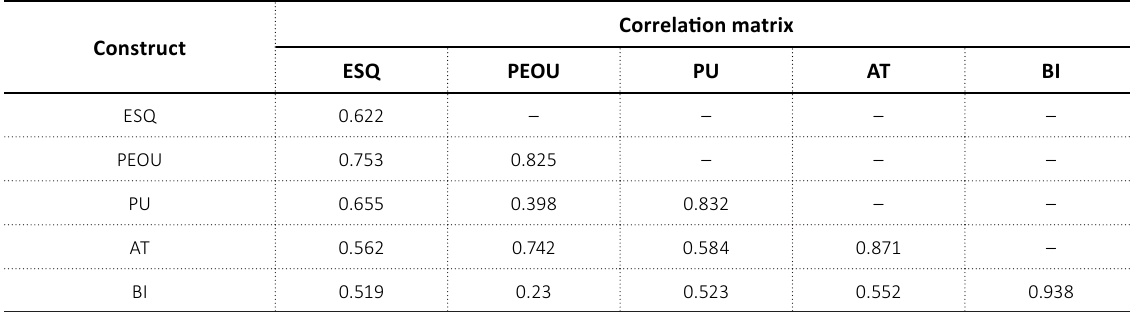
Table 3. Assessment of discriminant validity Construct